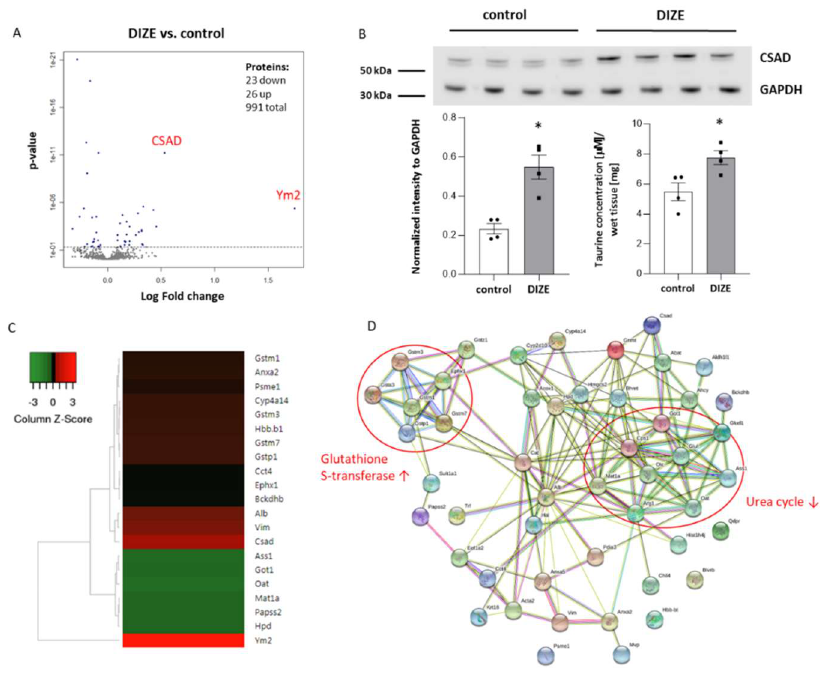
Figure 6. Proteomic analysis in the liver of DIZE-treated mice. The volcano plot of differentially expressed proteins showing the log2 fold change of protein expression vs. p -value in DIZE group compared to control mice ( A ). Validation of cysteine sulfinic acid decarboxylase (CSAD) expression by Western blot as well as the taurine levels in the liver of DIZE-treated mice ( B ). Heat map presentation of a hierarchical cluster of significantly changed proteins in the liver of DIZE-treated mice ( C ) (fold change >1.15 and < − 1.15). Bioinformatic analysis by STRING of differentially expressed proteins reveals decreased expression of urea cycle proteins and increased expression of different isoforms of glutathione S-transferase ( D ). Data are mean ± SEM analyzed using t -test ( B ) or one-way ANOVA with Benjamini and Hochberg false discovery rate (FDR) correction ( A , C ) (* p < 0.05 as compared to control mice; n = 4 per group). Table 1. Differentially expressed proteins in the liver of apoE −/− mice treated with DIZE as compared to the control group ( p < 0.05, n = 4 per group). UniProtKB ID.